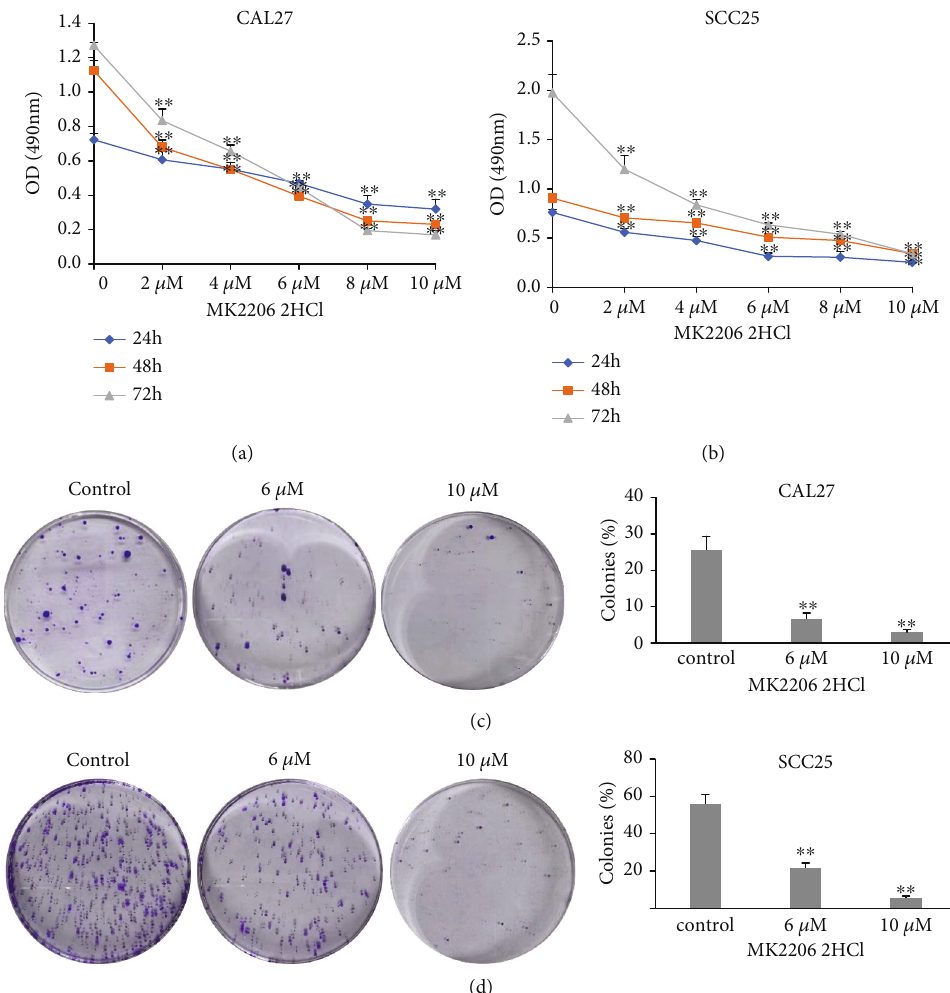
Figure 6: Growth-inhibitory e ff ect of MK2206 2HCl on OSCC cell lines. (a) MK2206 2HCl treatment inhibited CAL27 cell proliferation, determined by MTT assay. (b) MK2206 2HCl treatment inhibited SCC25 cell proliferation, determined by MTT assay. (c) Colony formation assay showed that MK2206 2HCl inhibited colony formation of CAL27 cells. (d) The colony formation assay showed that MK2206 2HCl inhibited colony formation of SCC25 cells. All data are presented as the mean ± SD : ∗∗ P < 0 : 01 as compared with the control